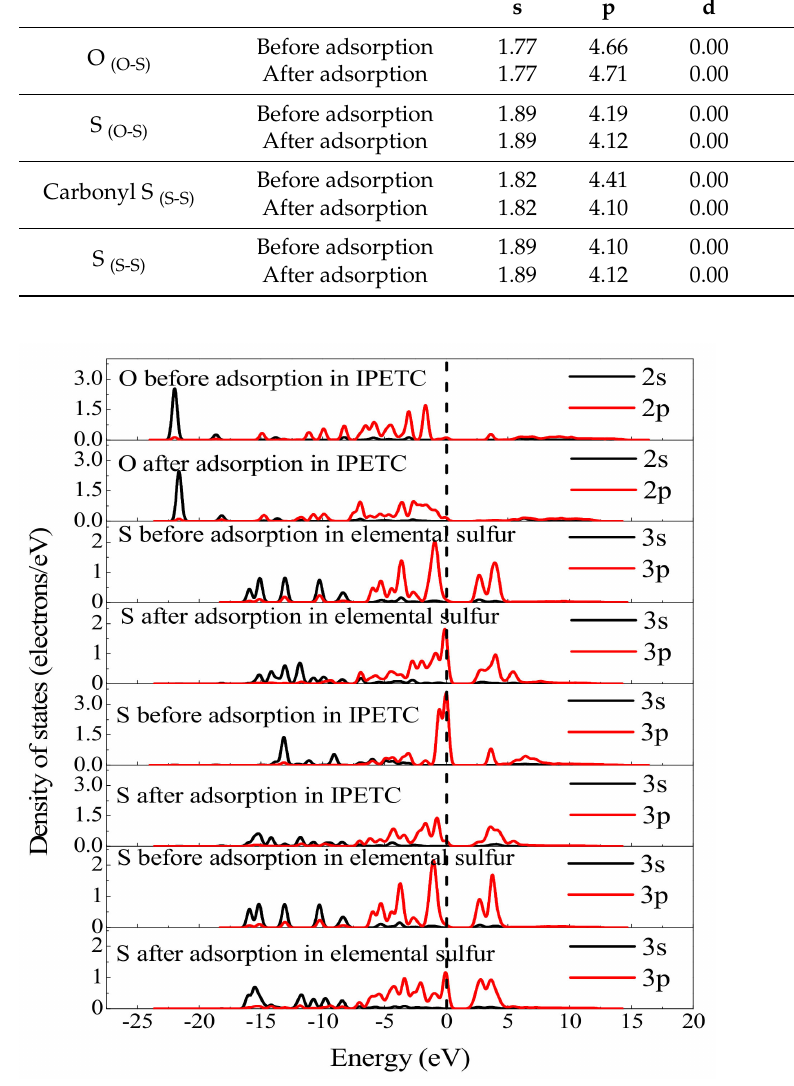
Figure 11. Densities of states of bonding atoms before and after IPETC adsorption on elemental sulfur (100)